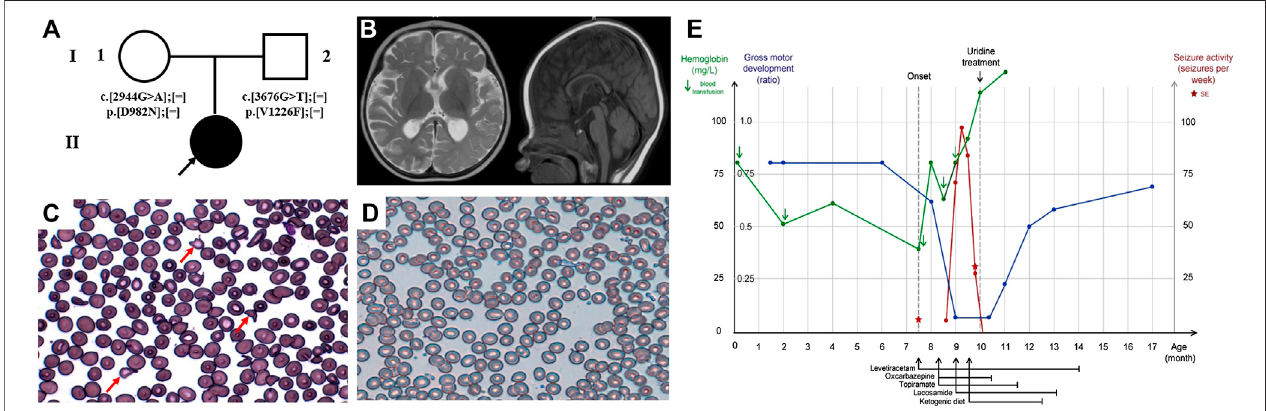
FIGURE 1 | Clinical features and uridine response of patient 1 with CAD de fi ciency. (A) Family pedigree of patient 1. (B) Brain MRI at 10-months. Peripheral blood smear (C) before treatment and (D) after treatment. (E) Clinical overview during the course of disease. Gross motor development represented as the observed development age according to the Nelson Gross Motor Development Milestones divided by the patient ’ s biological age (Feigelman,